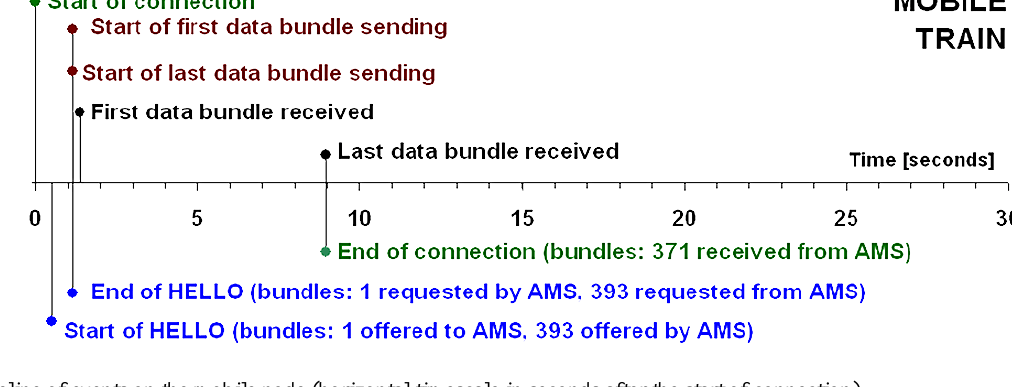
Fig. 8. Timeline of events on the mobile node (horizontal timescale in seconds after the start of connection).